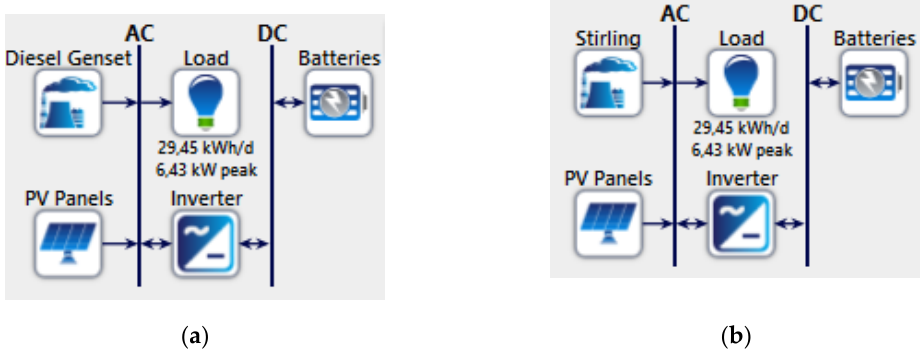
Figure 6. HOMER architecture of the hybrid power systems. ( a ) PV/diesel/battery; ( b ) PV/Stirling/battery.